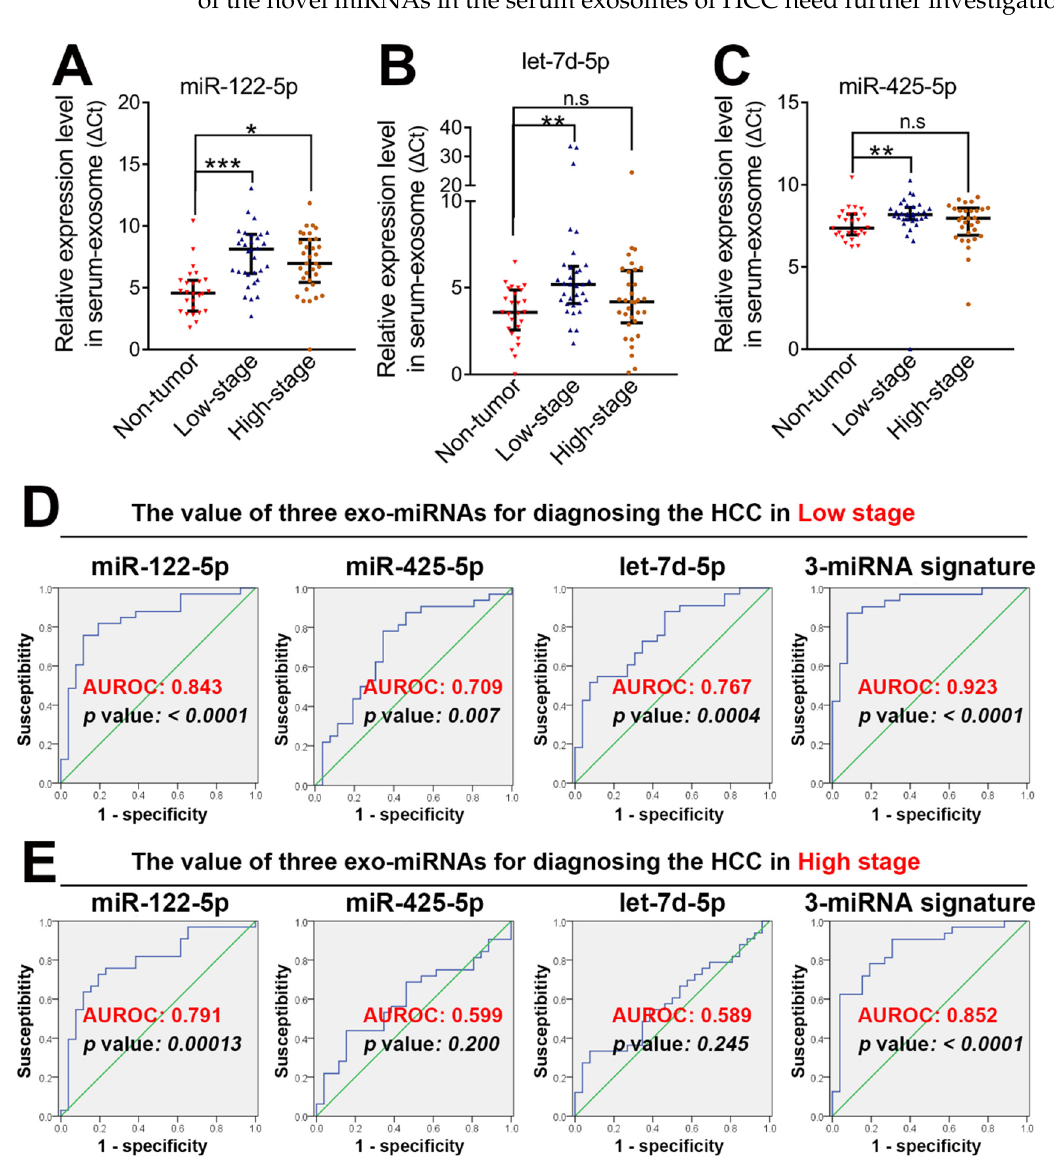
Figure 5. Three serum-exosome-derived miRNAs have significant values for the early diagnosis of HCC. ( A – C ): The expression of the three serum-exosome-derived miRNAs in non-tumor donors, low-stage HCC patients, and high-stage HCC patients. ( A ): miR-122-5p; ( B ): let-7d-5p; ( C ): miR-425-5p. ( D , E ): The value of the three serum-exosome-derived miRNAs for diagnosing low-stage ( D ) or high-stage HCC ( E ). *, **, and *** were used to represent p value of < 0.05, < 0.01, and < 0.001, respectively.